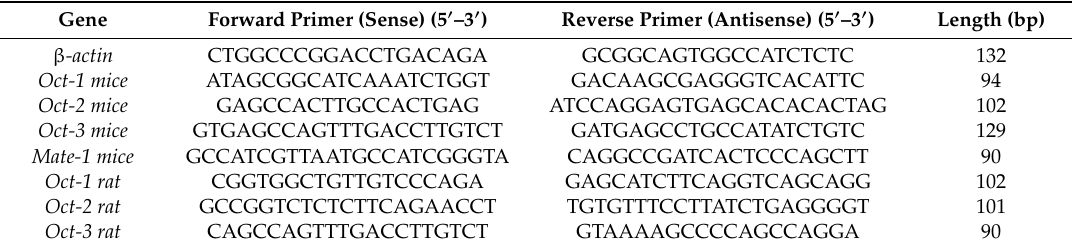
Table 1. Primer Sequences Used for SYBR Green-Based quantitative Real Time-Polymerase Chain Reaction